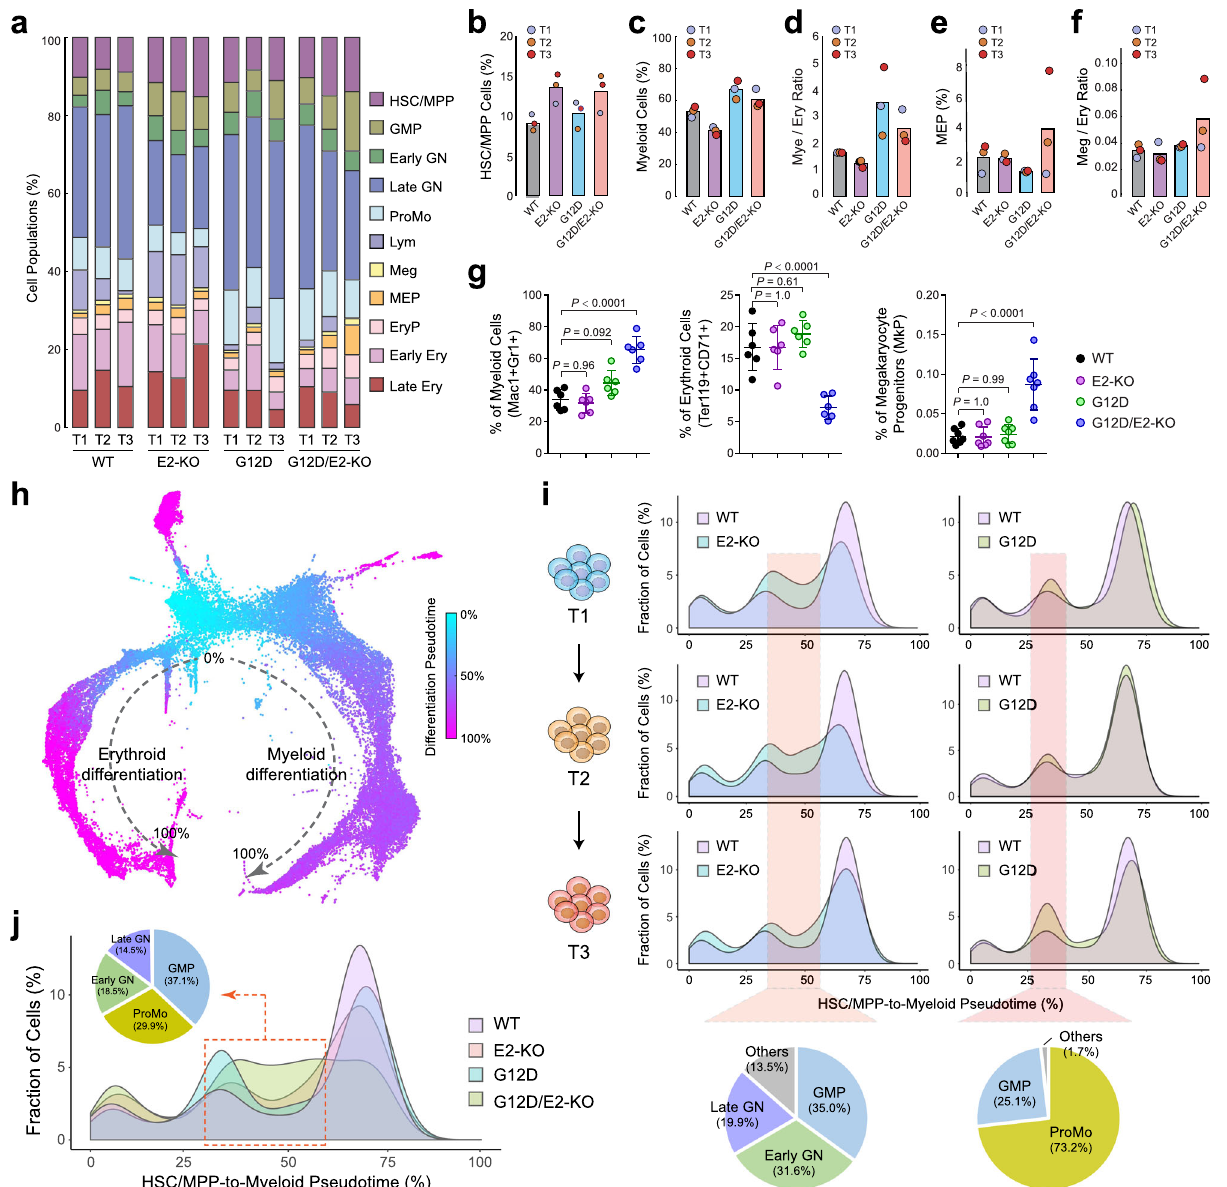
Fig. 3 Functional cooperation between NRas G12D and EZH2-de fi ciency impaired hematopoietic lineage differentiation. a The frequencies of annotated cell populations in WT or mutant HSPCs at different time points (T1 – T3) are shown. b EZH2-de fi ciency increased the frequency of HSC/MPP population in E2-KO and G12D/E2-KO HSPCs. Bars indicate the mean % of HSC/MPP cells of all time points and colored circles represent individual time points. c Expression of NRas G12D increased the frequency of myeloid cells in G12D and G12D/E2-KO HSPCs. d Expression of NRas G12D increased the myeloid to erythroid cell ratio in G12D and G12D/E2-KO HSPCs. Bars indicate the mean ratio of myeloid cells of all time points and colored dots represent individual time points. e NRas G12D and EZH2-de fi ciency increased the frequency of MEPs in G12D/E2-KO HSPCs. f NRas G12D and EZH2-de fi ciency increased the megakaryocytic (Meg) to erythroid (Ery) cell ratio in G12D/E2-KO HSPCs. g The frequencies of myeloid (Mac1 + Gr1 + ), erythroid (Ter119 + CD71 + ) and megakaryocyte progenitor cells (MkP, Lin − c-Kit + CD150 + CD41 + ) were determined by fl ow cytometry in mouse bone marrows at 10 weeks post-pIpC or moribund. Results are mean ± SD ( N = 6 mice per genotype for myeloid and erythroid cells and N = 7 mice per genotype for MkP) and analyzed by one- way ANOVA with multiple comparisons. h Differentiation pseudotime of myeloid and erythroid lineages predicted by PAGA. The KNN plot is color-coded by pseudo-temporal order starting from the most immature HSC/MPP cells to mature cells of different lineages. i Comparisons of cell density distribution in E2-KO (or G12D) and WT HSPCs along the HSC/MPP-to-myeloid differentiation pseudotime at T1 – T3 time points. Pie charts show the cellular composition of the enriched cell populations in E2-KO or G12D HSPCs at T3. j The cell density distribution along the HSC/MPP-to-myeloid differentiation pseudotime is shown for the indicated genotypes at T3. Pie chart shows the cellular composition of the enriched cell populations in G12D/E2-KO HSPCs at T3. Source data are provided as a Source Data fi